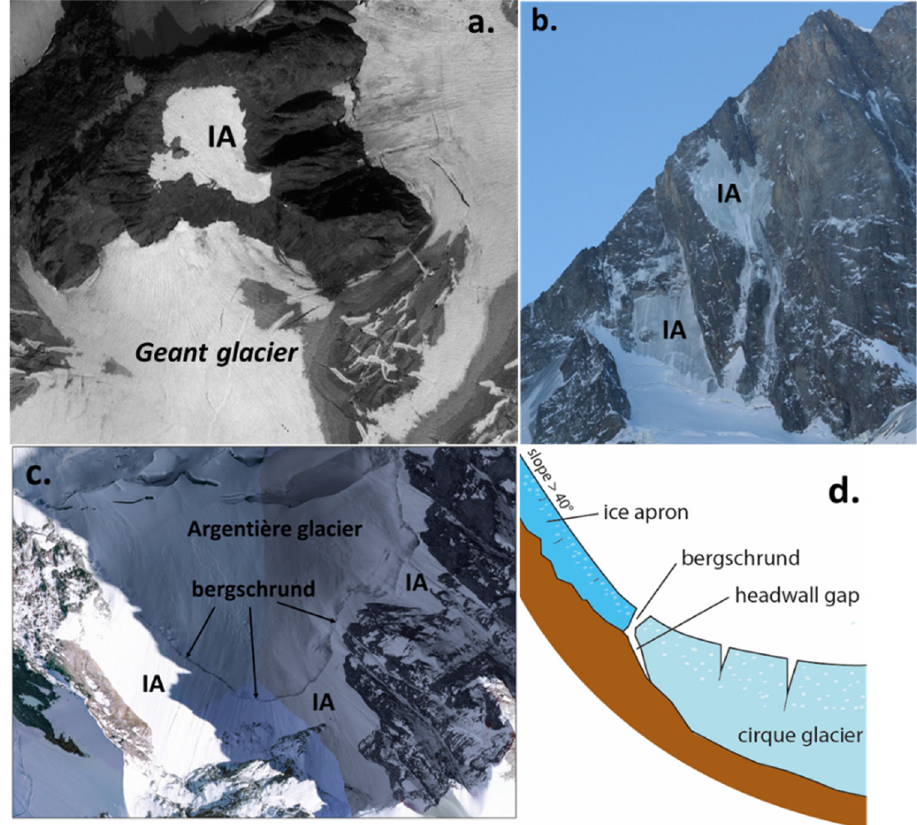
Figure 5. The three types of IAs. ( a ) Type 1: IA located on the south face of Gros Rognon (3541 m a.s.l.) on a rock wall associated with a large glacier; ( b ) Type 2 : IA on the north face of the Grandes Jorasses (4208 m a.s.l.); and ( c ) Type 3: IAs on the headwall of the Argentière glacier